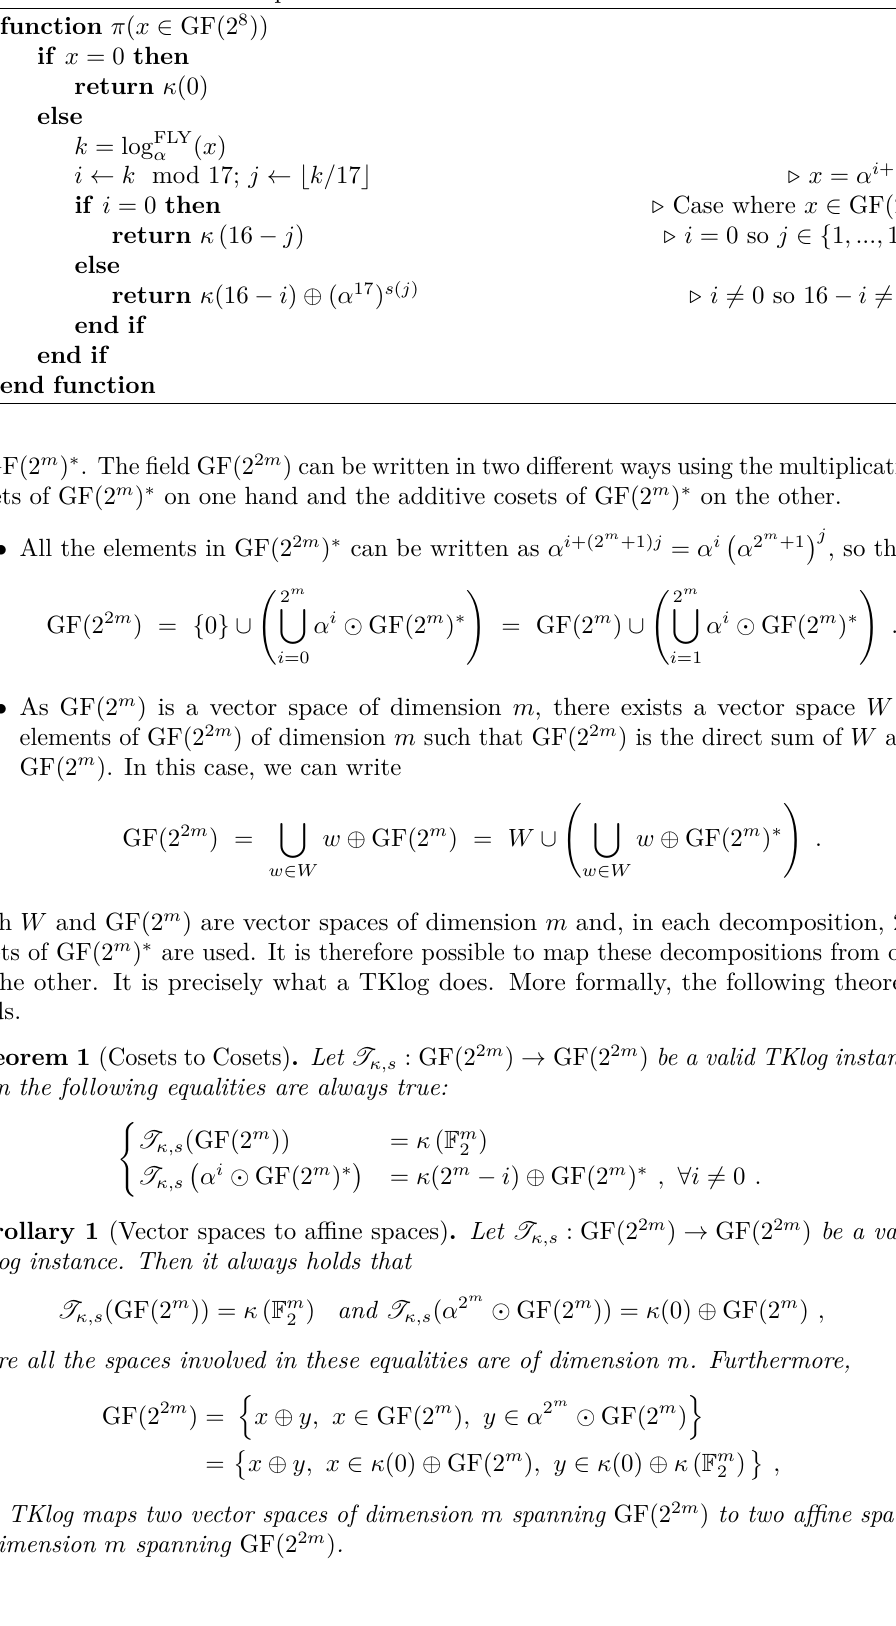
Algorithm 1 A new decomposition of 𝜋